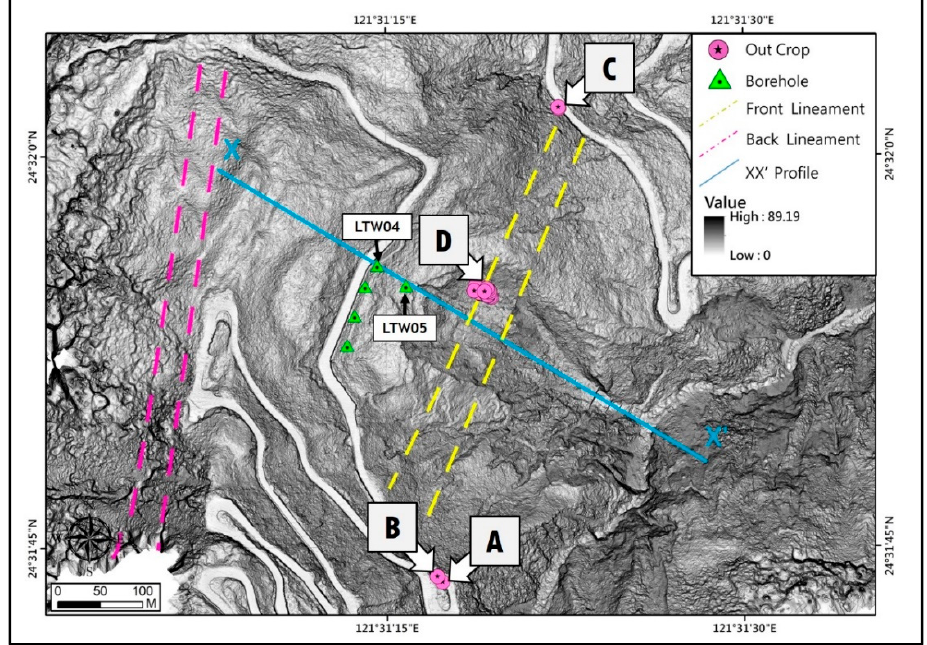
Figure 12. The two sets of lineaments on opposite slope surfaces of the ridge were projected on the planar slope map derived from DTMH using approximate straight lines (WGS 84 coordinates). The field investigation points A, B, C, and D are indicated as pink dots, and green triangles indicate locations of boreholes. The X-X’ profile was used for stability analysis.